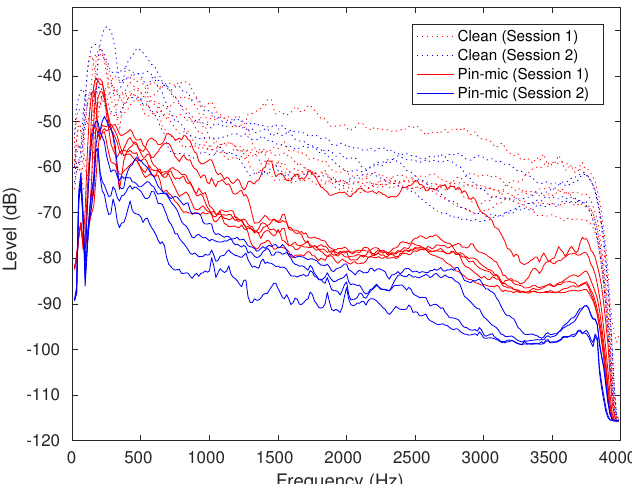
Figure 9. Spectral analysis of wireless original clean data and re-recordings through pin mic channels after down